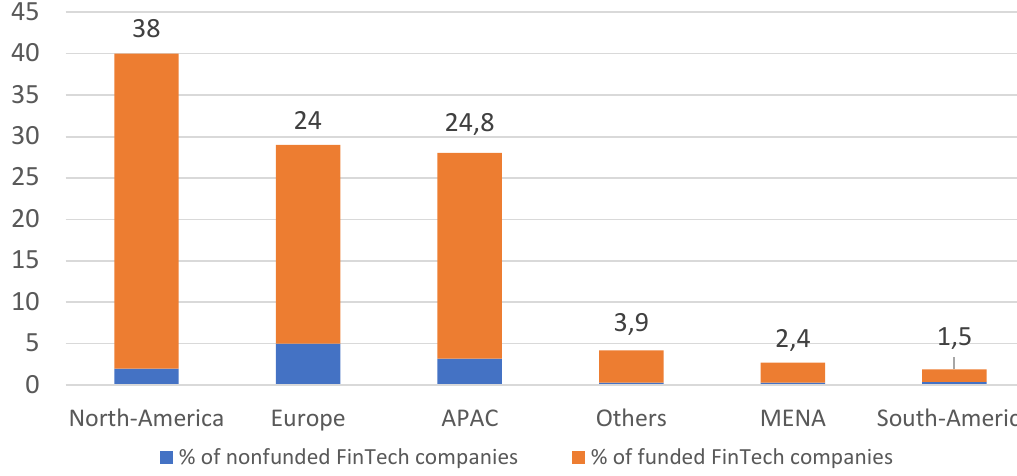
Source: Sloboda, Dunas, and Limański